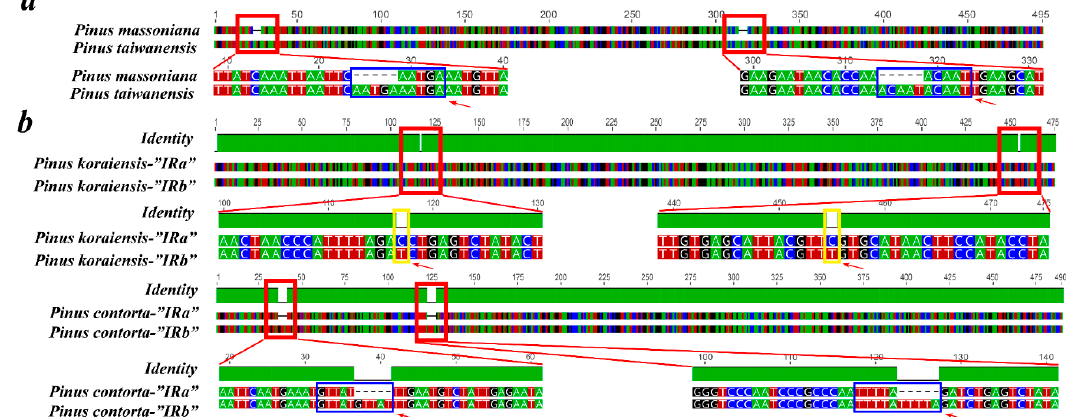
Figure 5. Variations of inverted repeats (IRs) using multiple alignment. ( a ) Variations between P. massoniana and P. taiwanensis ; ( b ) variations between “IRa” and “IRb” in P. koraiensis and P. contorta . Variations are in red frames: Single Nucleotide Polymorphisms (SNPs) are in yellow frames; microsatellites are in blue frames.